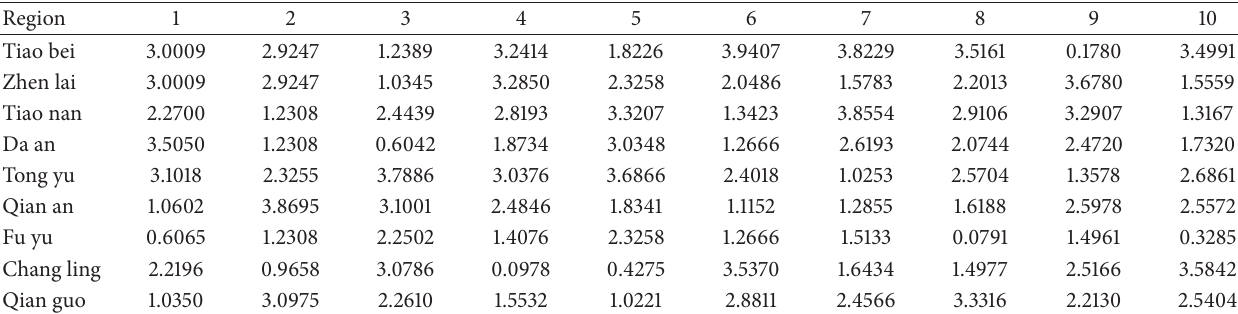
Table 3: Coordinate translation.